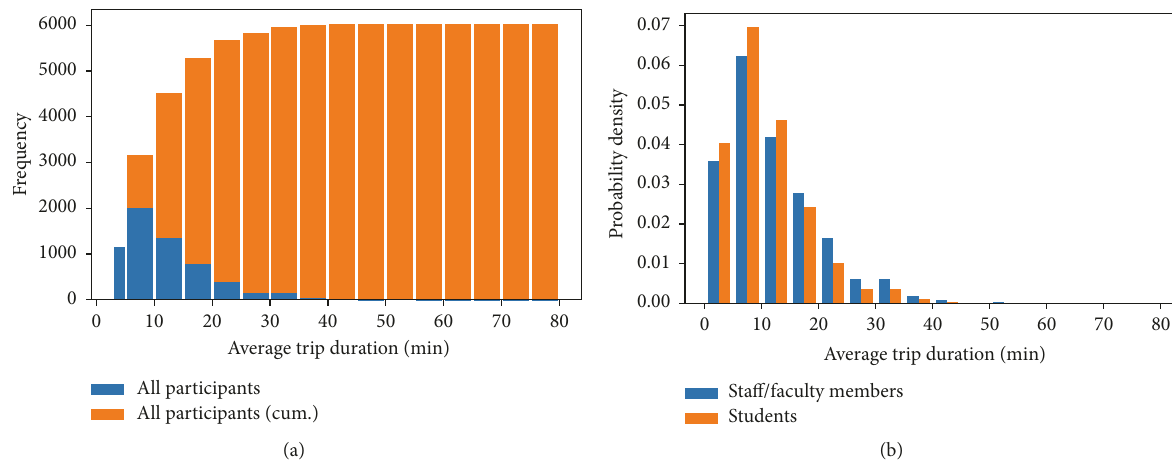
Figure 3: (a) Trip duration (cumulative) frequency; (b) trip duration probability distribution split by occupation. All plots are shown on a minute